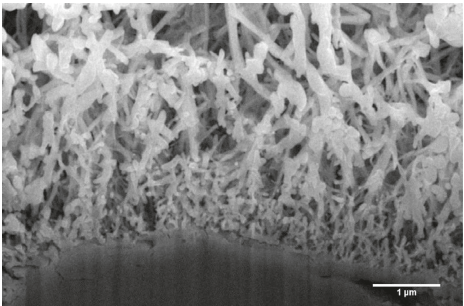
Figure 7: Cross-sectional SEM images of NaNbO 80 ° C, for 24h with NaOH concentration of 0.50M after heat treatment, presenting the increase of the nanowires diameter along the layer thickness.